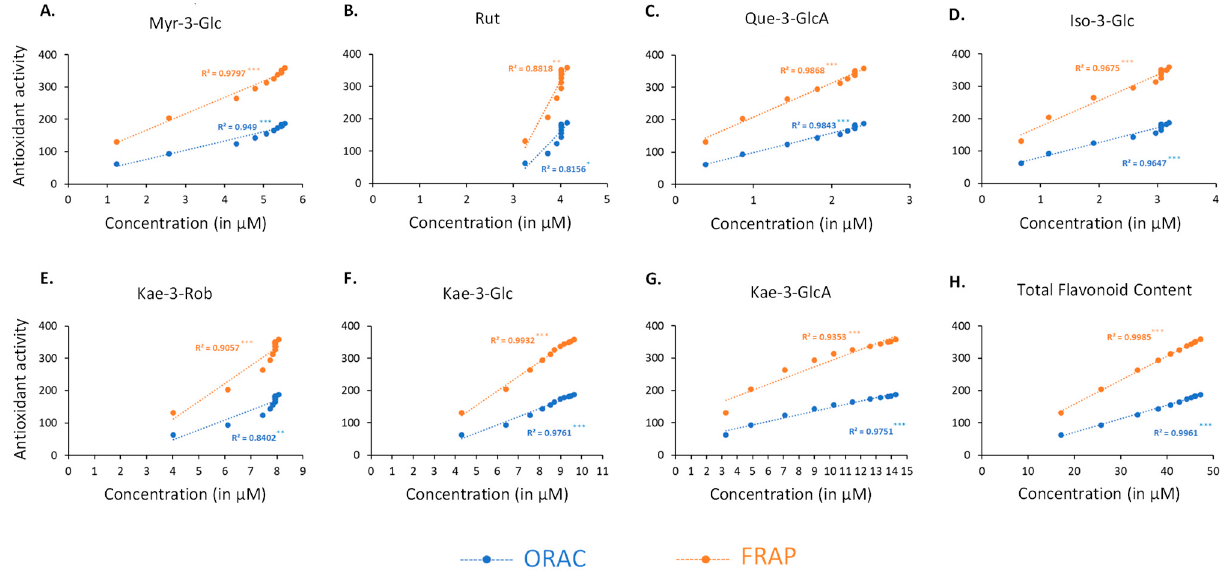
Figure 5. Correlation of antioxidant activity (ORAC (blue line) and FRAP (orange line) assays) with the concentration of Myr-3-Glc ( A ), Rut ( B ), Que-3-GlcA ( C ), Iso-3-Glc ( D ), Kae-3-Rob ( E ), Kae-3-Glc ( F ), Kae-3-GlcA ( G ) and total flavonoids ( H ). Myr-3-O-Glc: myricetin-3-O-glucose; Quer-3-O-Rut: quercetin-3-O-rutinoside (rutin); Quer-3-O-GlcA: quercetin-3-O-glucuronic acid; Kae-3-O-Rob: kaempferol-3-O-robinobiose; Kae-3-O-Glc: kaempferol-3-O-glucose; Kae 3-O-GlcA: kaempferol 3-O-glucuronic acid; Iso-3-O-Glc: isorhamnetin-3-O-glucose; Glc: glucose; GlcA: glucuronic acid; Rob: robinobiose.